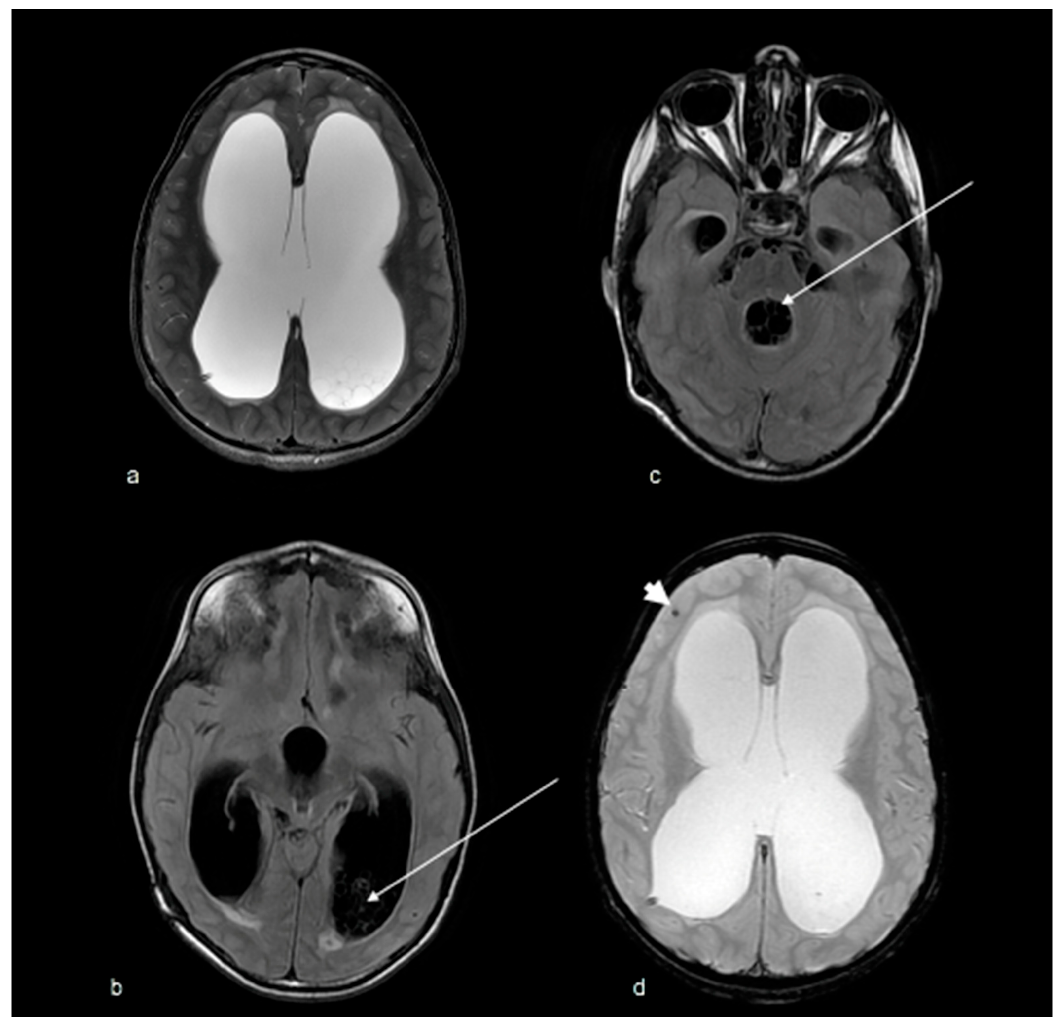
Figure 3. ( a ) T2 axial MRI and ( b – c ) FLAIR axial MRI brain demonstrates acute hydrocephalus with a re-distribution of cysts (arrows) within the CSF spaces. ( d ) GRE axial MRI brain demonstrates a new isolated right frontal lobe lesion (arrowhead) that blooms on GRE, most likely in keeping with a calcified granuloma.